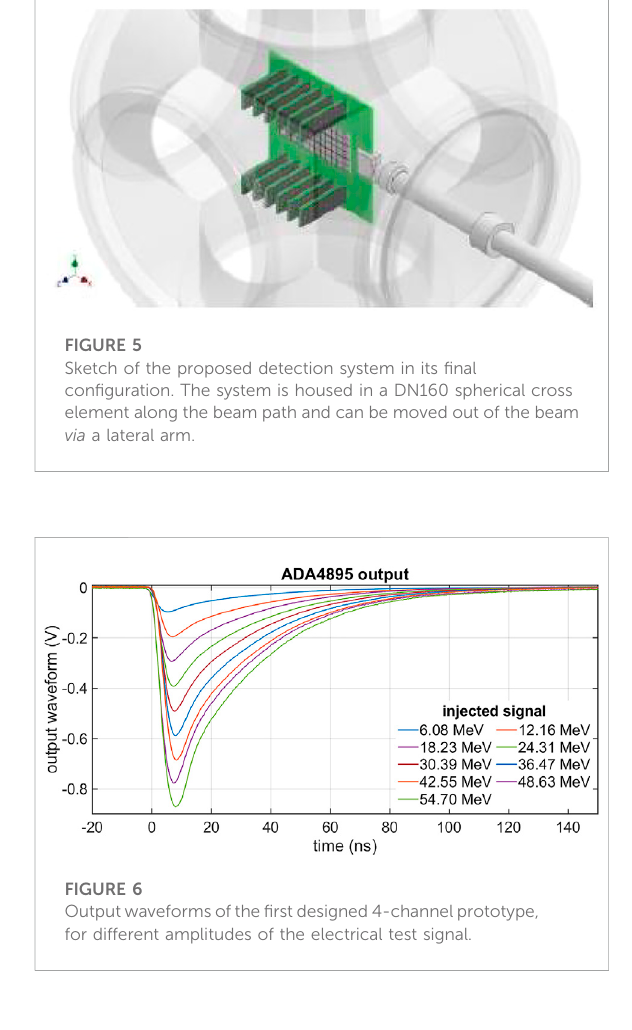
TABLE 2 Primary beams, whose extraction by stripping has been studied in detail, with relative energy and power used as input for the